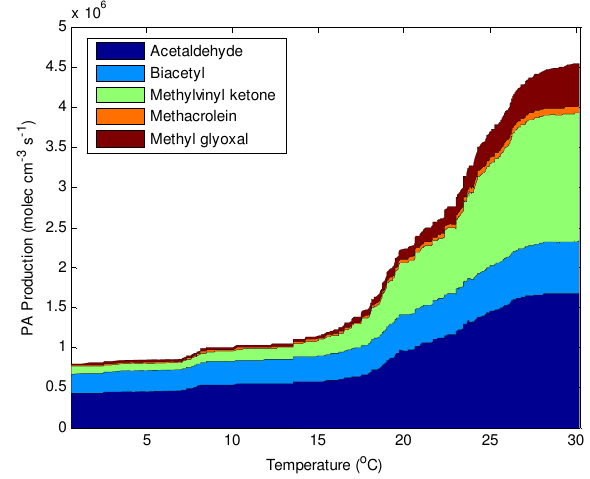
Fig. 4. Behavior of different PA production sources vs temperature. Mechanisms for each production route are shown in Scheme 2. This figure is obtained by using a running average with temperature of the calculated production rates from observations of